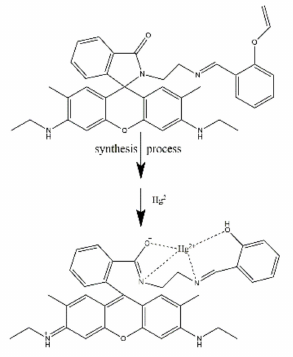
Figure 3. The possible mechanism of RDV (Table 1, No. 4) to Hg 2+